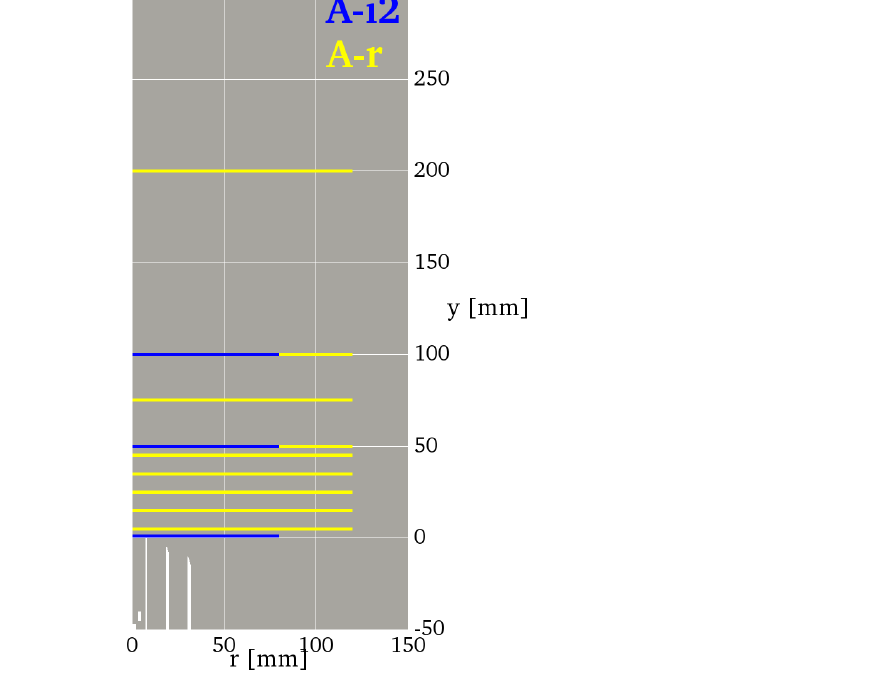
Figure 5. Axial locations where experimental measurements of conditions A-i2 (blue) and A-r (yellow) of Table 1 are